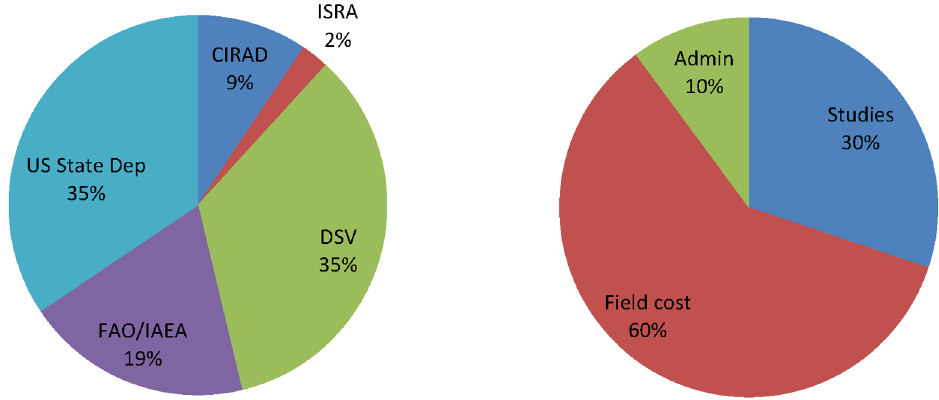
Figure 5. Distribution of the costs by partner (left) and component (right).